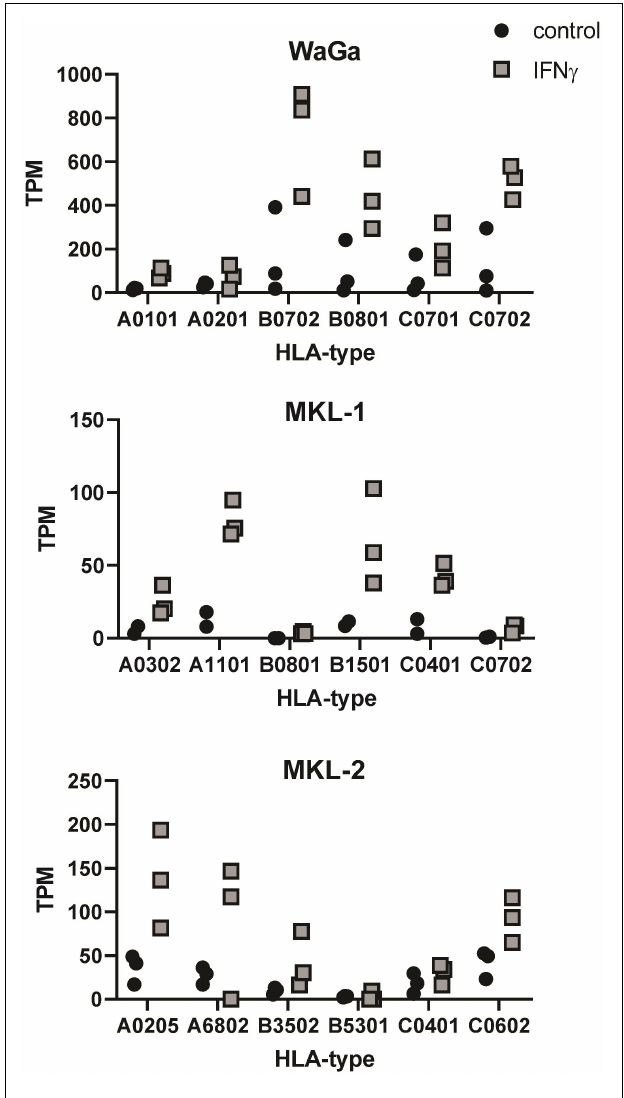
FIGURE 5 | Detection of HLA expression after IFN γ incubation on mRNA level. Transcripts per million (TPM) values of six different HLA alleles after IFN γ treatment (gray squares) or without IFN γ incubation (black dots) are depicted for each MCC cell line. TPM values were acquired from our sequencing output using a new two-pass quantification method. For each cell line, three independent experiments were performed (two for MKL-1 control), so that each symbol represents one replicate of the respective cell